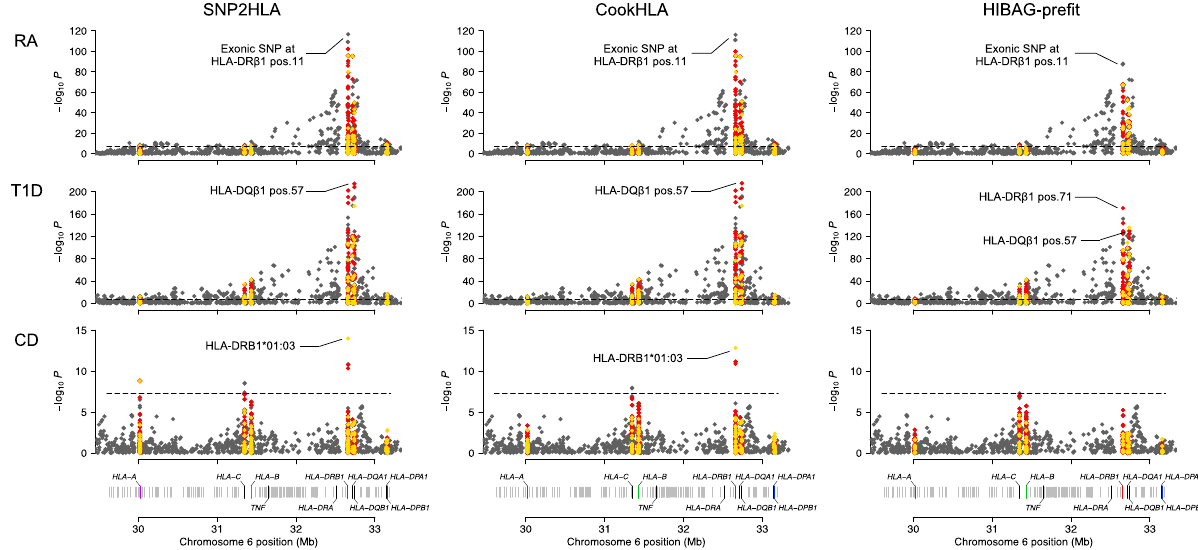
Fig. 5 Association analysis of the WTCCC data. We used different imputation methods to impute HLA of the WTCCC data and performed HLA fi ne- mapping analysis for three autoimmune diseases. RA rheumatoid arthritis, T1D Type 1 diabetes, CD Crohn ’ s